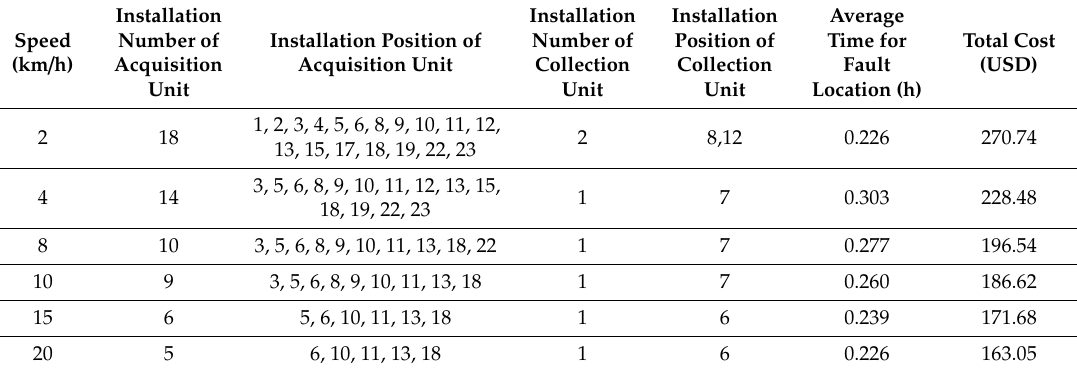
Table 2. Optional placement of fault indicators under di ff erent speed of patrolling the